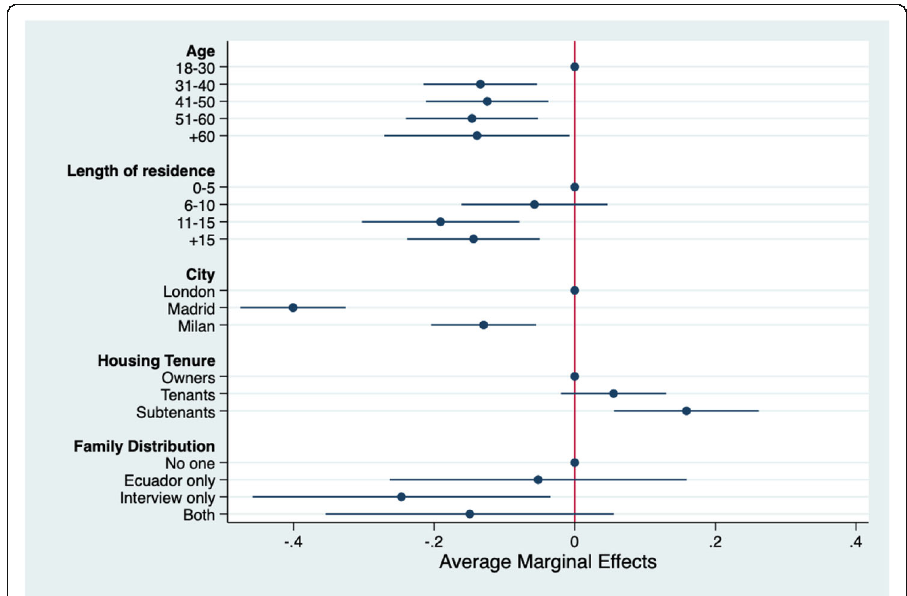
Fig. 1 Average marginal effects of independent variables on the probability of “ non-dwelling ”